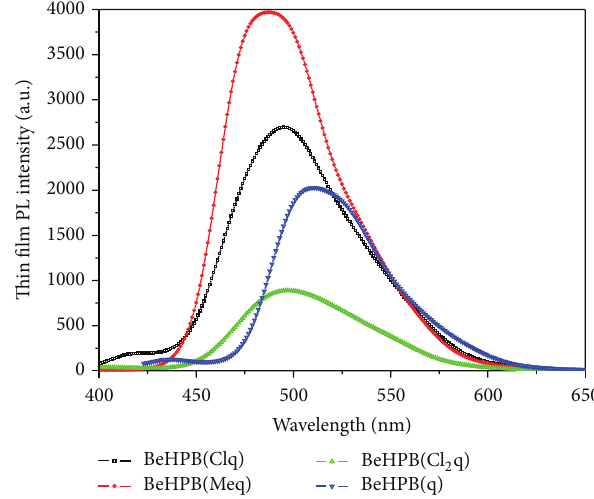
Figure 4: Energy versus absorption 2 plot of beryllium complexes.